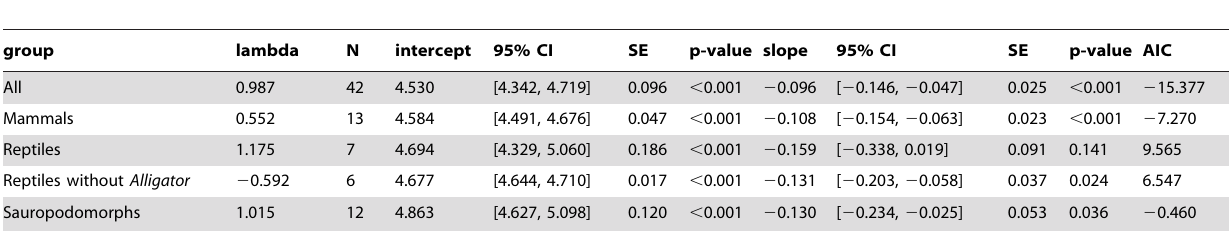
Table 3. Phylogenetic controlled regression models (log10 OLD =log10 intercept + slope * log10 BM) of osteocyte lacunar density (OLD) on body mass (BM) for different